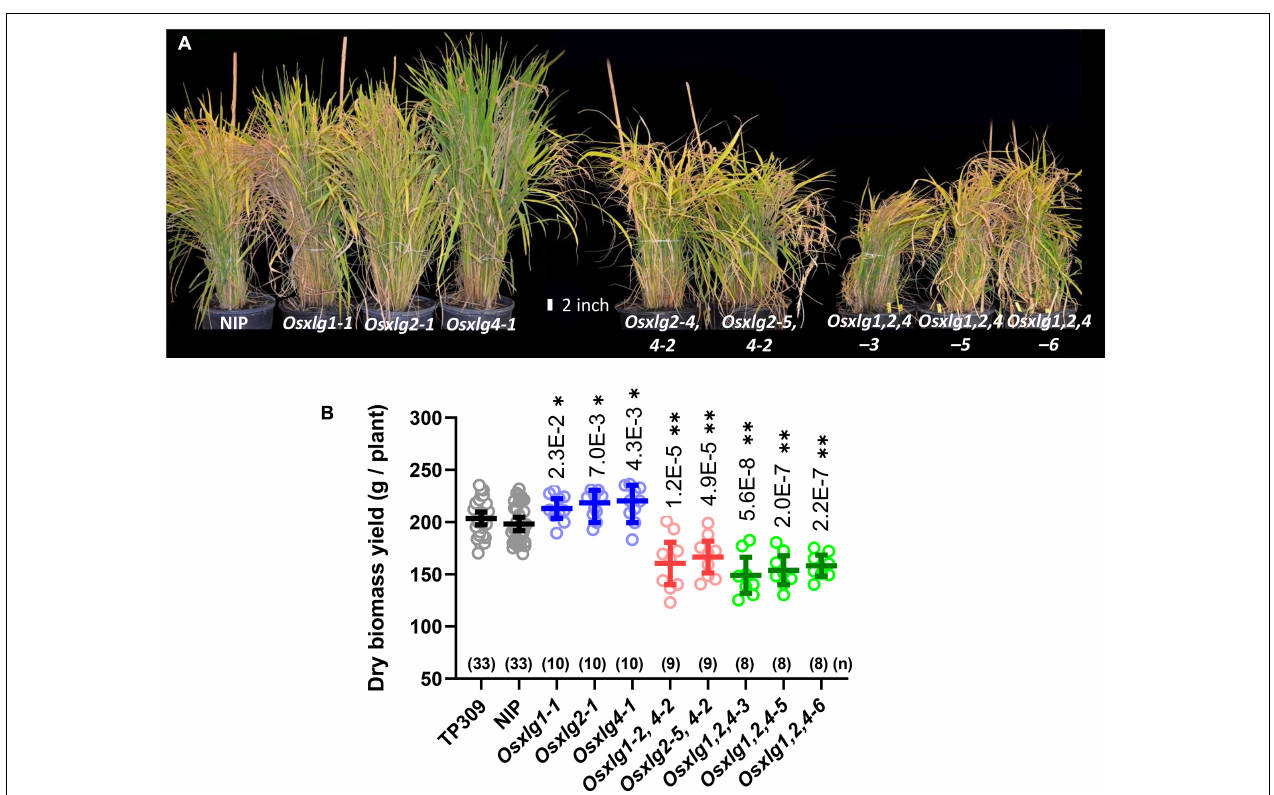
FIGURE 7 | Growth phenotypes and dry aerial weight of rice Osxlg plants. Growth phenotypes and dry aerial biomass weight of 125-day-old rice WT NIP, Osxlg single, double, and triple mutant greenhouse grown plants (A) . The raw values of controls and Osxlg mutants are shown in (B) . The horizontal lines indicate the means, the error bars represent 95% confidence intervals, and ( n ) is the sample size. Significant differences between WT-NIP and Osxlg mutants were determined by statistical analysis using Statistica 5.0 with one-way ANOVA followed by Tukey’s multiple comparison test. p- values are expressed as ∗ P < 0.05, ∗∗ P <